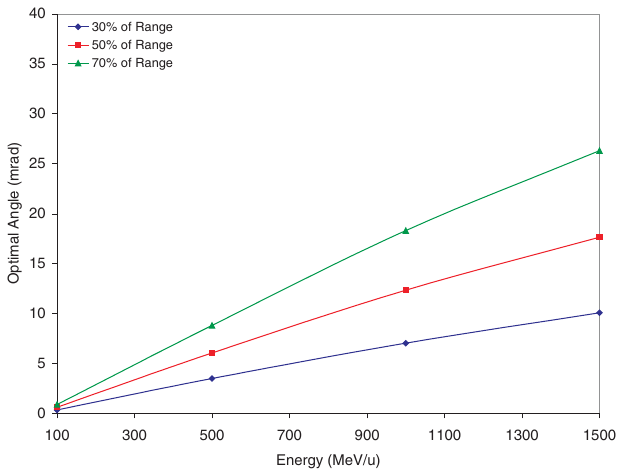
FIG. 4. (Color) Optimal angle needed to maintain linear achro- maticity for the case of a 100 Sn beam at various energies and three different wedge thicknesses.